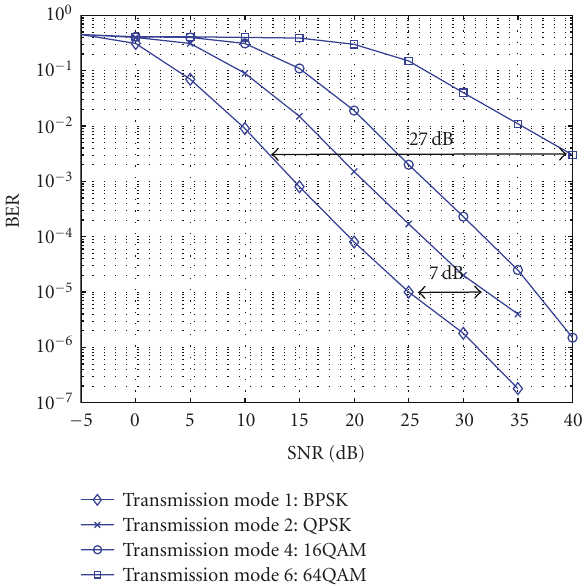
Figure 12: BER comparison for di ff erent IEEE 802.16 transmission modes using 2 × 2 MIMO.